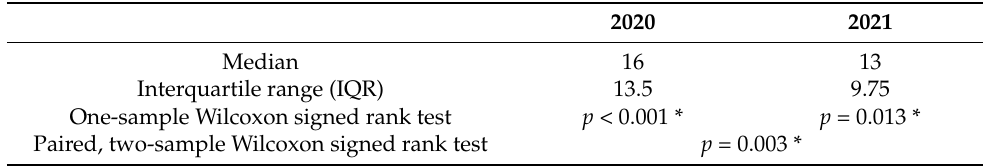
Table 2. Descriptive summary statistics for As levels in selected wells surrounding Taal volcano as compared to the national standard, and comparing 2020 vs.